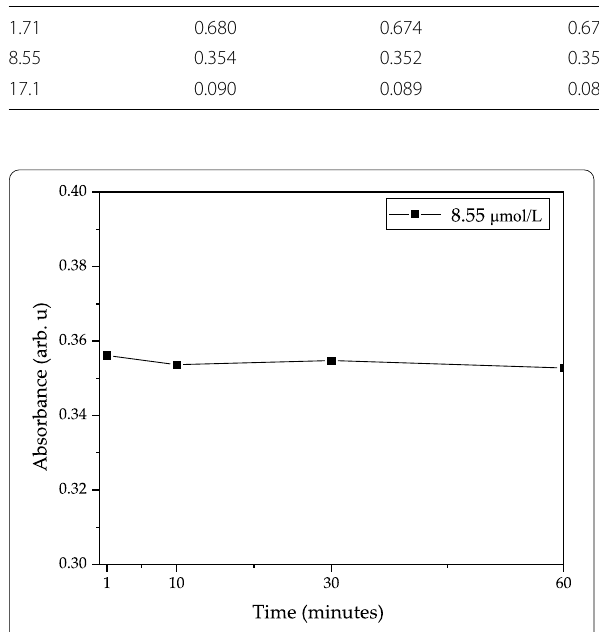
The absorbance for a second test (arb. u)